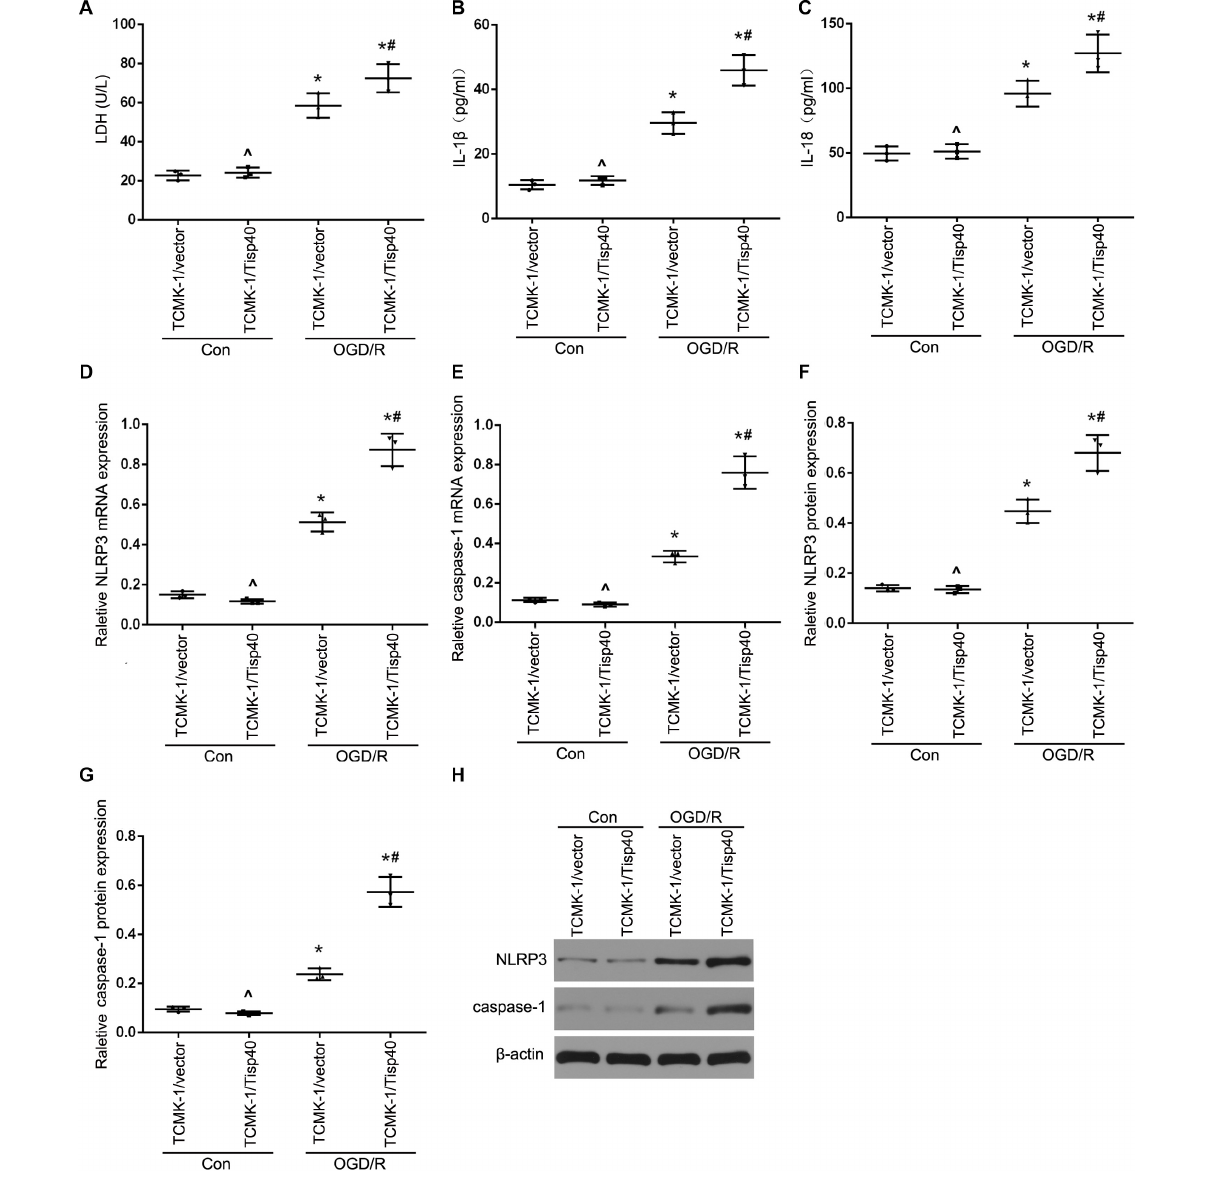
FIGURE 3 | Tisp40 enhanced NLRP3 inflammasome activation in cultured OGD/R-stimulated TCMK-1 cells. (A) The LDH release was detected by activity assays. IL-1 β (B) and IL-18 (C) contents were measured by using ELISA kits. (D–H) The expression of NLRP3 and caspase-1 were analyzed by qRT-PCR and western blot. Data are expressed as the mean ± SD. n = 5 per group. * P < 0.05 vs. corresponding control groups (Con). ∧ P > 0.05 vs. TCMK-1/vector in con group. # P < 0.05 vs. the group of TCMK-1/vector cells induced by OGD/R, one-way